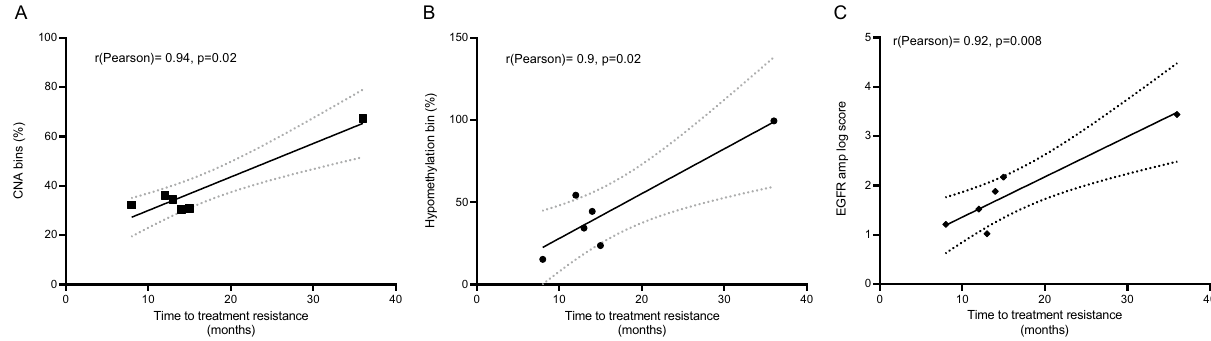
Figure 3. Accumulation of genetic and epigenetic changes in cases with EGFR amplification correlated with the duration of response to TKI treatment. ( A – C ): Linear regression and Pearson’s correlation between proportion of CNA bins ( A ), hypo-methylated bins ( B ), EGFR amplification scores ( C ) and time to treatment resistance (TTTR) in 6 cases with EGFR amplification including 3 cases with co-occurring with on-target mutations could be accumulated during the response to TKI drug treatment and may play impor- tant roles in the acquisition of resistance. Thus, we examined the correlation between these changes and the time to treatment resistance (TTTR). Since the levels of hypo-methylation and CNA were similar between EGFR amplification cases and those carrying co-occurring T790M and EGFR amplification, we put these samples into the same EGFR amplification group for the correlation analysis. Although both EGFR amplification and T790M cases displayed extensive changes in hypo-methylation and CNA, only EGFR amplification cases showed signifi- cantly positive correlations between CNA or hypo-methylation changes with TTTR (r = 0.94, 95% CI 0.6–0.99, p = 0.004 for CNA, Fig. 3A; r = 0.9 95% CI 0.3–0.98, p = 0.02 for hypo-methylation, Fig. 3B; insignificant cor- relations, p > 0.05 in T790M cases, Fig. S4A,B). Moreover, we found that the abundance of EGFR amplification mutations but not T790M in plasma significantly correlated with TTTR (r = 0.92, 95% CI: 0.5–0.99, p = 0.008, Fig. 3C for EGFR amplification cases and r = -0.18, p > 0.05; insignificant correlation, p > 0.05 for T790M cases, Fig. S4C). These results suggested that changes in DNA hypo-methylation and CNA concurrently occurred with EGFR amplification and were gradually accumulated during the treatment with TKI drugs. This process may be required to ensure the survival of tumor cells before acquiring the resistance. Distinct hyper‑methylation of transcriptional regulatory regions of cancer related genes in patients with EGFR dependent and independent resistance mutations. The acquisition of resist- ance to TKI might be associated with changes in expression of many genes, which could be affected by the methylation states of their transcriptional regulatory regions 23,24 . To identify such genes, we designed a panel of capture probes targeting 450 regions (Table S2) which were selected based on their significant contributions to cancer carcinogenesis reported by previous publications 32–37 . The majority of regions contain CpG islands overlapping or located in close proximity to promoter regions of cancer related genes including oncogenes and tumor suppressor genes. Distinct methylation patterns were observed in cases with on-target resistance muta- tions compared to those carrying off-target mutations, which showed methylation profiles similar to healthy control subjects (Fig. 4A). A total of 260 differentially methylated regions (DMR) out of 450 regions (57.8%) were identified when comparing on-target and off-target mutation groups. Of those, the majority (202 DMR) were significantly hyper-methylated (log Pathway enrichment analysis by gProfiler was performed on the set of genes mapped by those DMR. We found that 202 hyper-methylated regions were enriched in 5 pathways from the REACTOME and KEGG database including pathways regulating activation of HOX genes (2 pathways), the transcriptional regulation by TFAP2, the pluripotency of stem cells and the maturity of onset diabetes of the young (Fig. 4B). The sets of genes associ- ated with those pathways were listed in Table S4. The activation of HOX genes and the regulation of transcrip- tion by TFAP2 pathways consisted of several component genes that were tumor suppressor genes involved in the regulation of tumor differentiation. The hyper-methylation at regulatory regions of such genes in cases with on-target resistance mutations could lead to the suppression of their expression, resulting in tumor progression. The functional contribution of the remaining two pathways to cancer tumorigenesis is not well understood. There was no significant pathway enriched by the 58 hypo-methylated DMR. The majority of those DMR were found to be fully methylated in cases with MET and HER2 amplification as well as healthy individuals, suggest- ing the re-activation of such genes in the on-target groups via reduced methylation at their promoter regions. These results showed that cases carrying resistance mutations in EGFR accumulated abundant hyper-methyla- tion changes in regulatory regions of tumor suppressor genes such as HOX genes to inhibit the differentiation of cancer cells during the acquisition of TKI resistance. By contrast, cases with HER2 and MET amplification developed resistance to TKI via mechanisms independent of the acquisition of hyper-methylation of such genes.